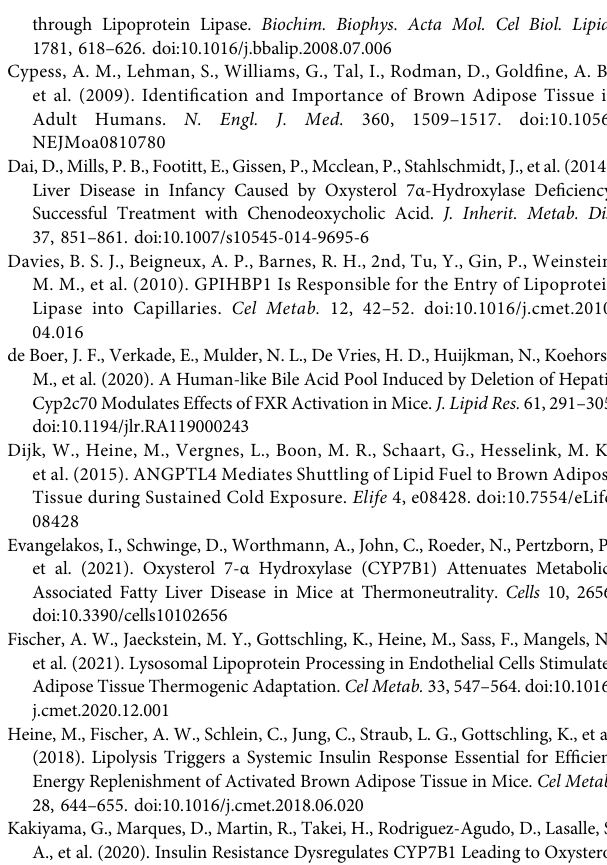
Supplementary Figure S1 | Absolute concentrations of individual bile acids detected in the plasma of wild-type (WT) and Cyp7b1 − / − littermates that were fed a Western-type diet (WTD) and housed for one week either at thermoneutral (30 ° C) or cold (6 ° C) environment (n=3-4/group). Data are shown as mean values ± SEM. Different letters indicate signi fi cant differences between groups (p < 0.05) determined by two-way ANOVA. SupplementaryFigureS2| Proteinlevelsandrelativequanti fi cation ofpCREBand CREB (A) and T3 levels (B) in BAT of WT (n=9) and Cyp7b1 − / − (n=8) littermates that werefedaWTDandhousedforoneweekatcold(6 ° C)environment.Dataareshown as mean values ± SEM. Different letters indicate signi fi cant differences between groups (p < 0.05) determined by two-way ANOVA. Supplementary Figure S3 | Protein levels and relative quanti fi cation of LPL and GPIHBP1 in the heart of WT (n=9) and Cyp7b1 − / − (n=8) littermates that were fed a WTD and housed for one week at cold (6 ° C) environment. Data are shown as mean values ± SEM. Different letters indicate signi fi cant differences between groups (p < 0.05) determined by two-way ANOVA. Supplementary Figure S4 | Graphical